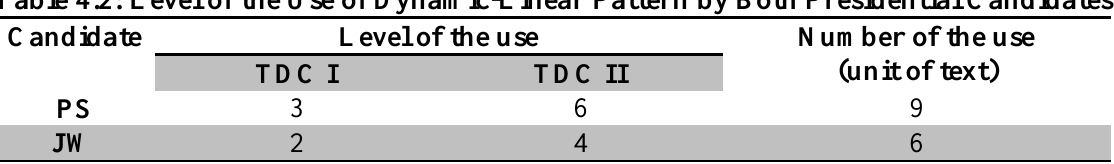
Table 4.2: Level of the Use of Dynamic-Linear Pattern by Both Presidential Candidates